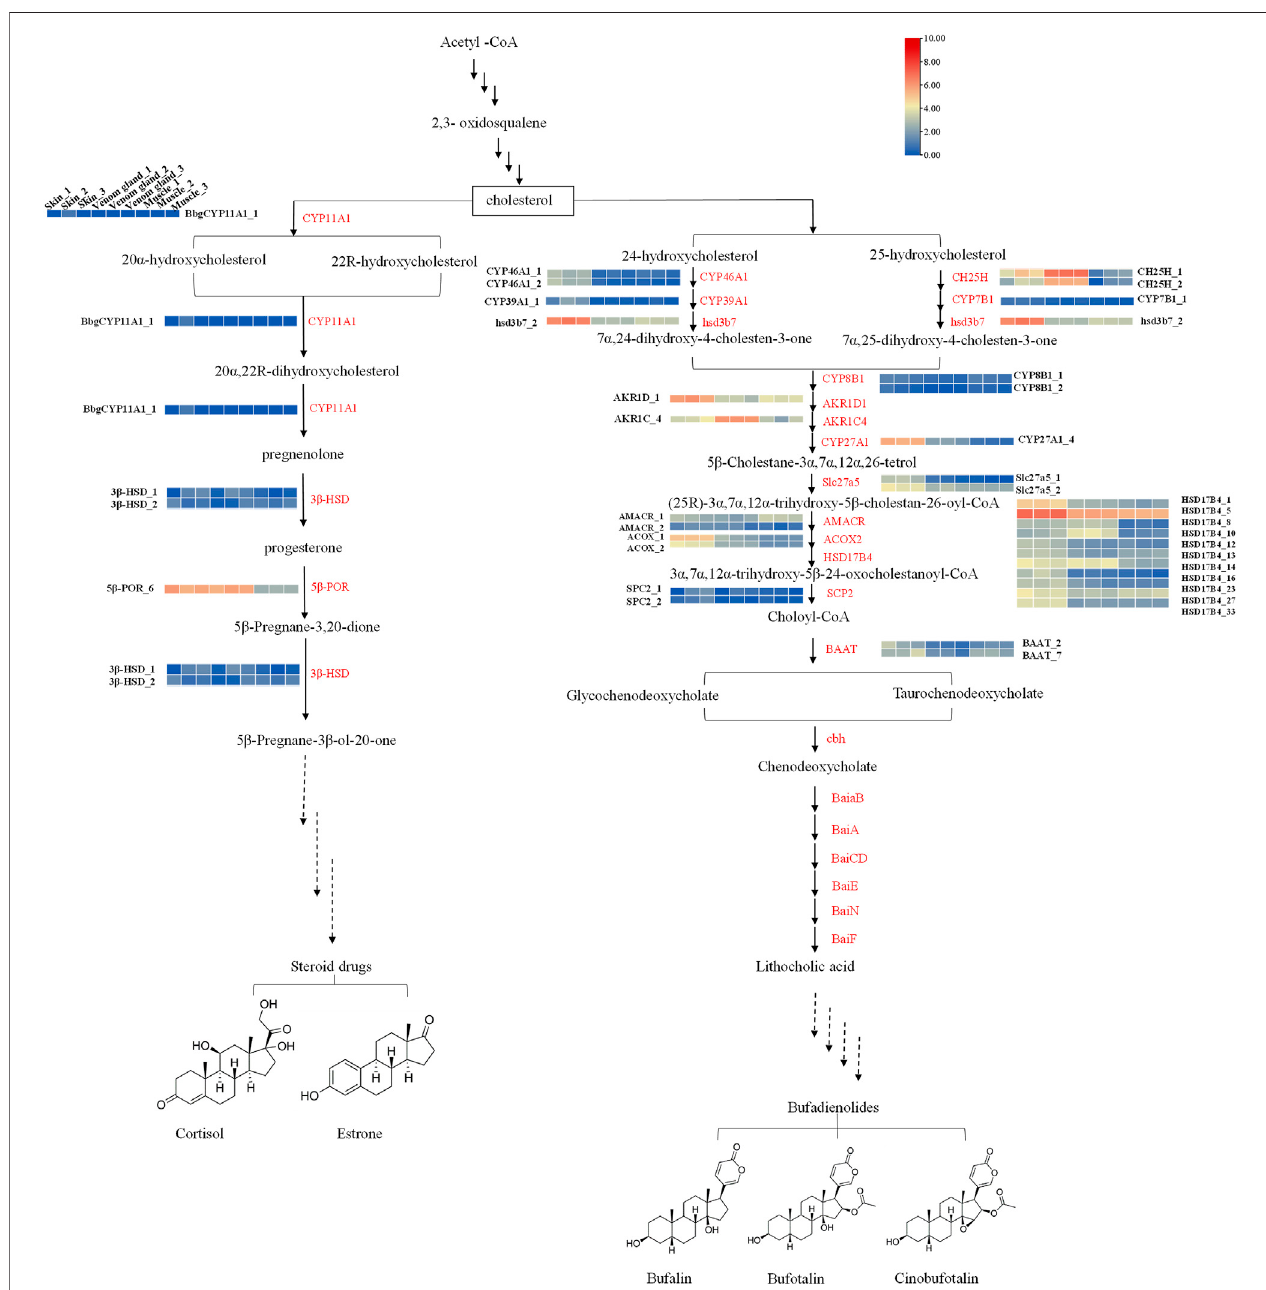
FIGURE 4 | The enzymes are possibly involved in pregnenolone and the bufadienolides biosynthesis pathway (Payne and Hales, 2004; Norlin and Wikvall, 2007). Heatmapsdisplaythedifferentialexpressionoftranscriptsencodingenzymesinvolvedindifferentsteps.Intheheatmaps,differentcolumnsrepresenttissuesinorderof skin, venom gland, and muscle from left to right. Color scale representing normalized expression values isshown at thetop. Thered names inthe pathways correspond to Supplementary Table S3 .